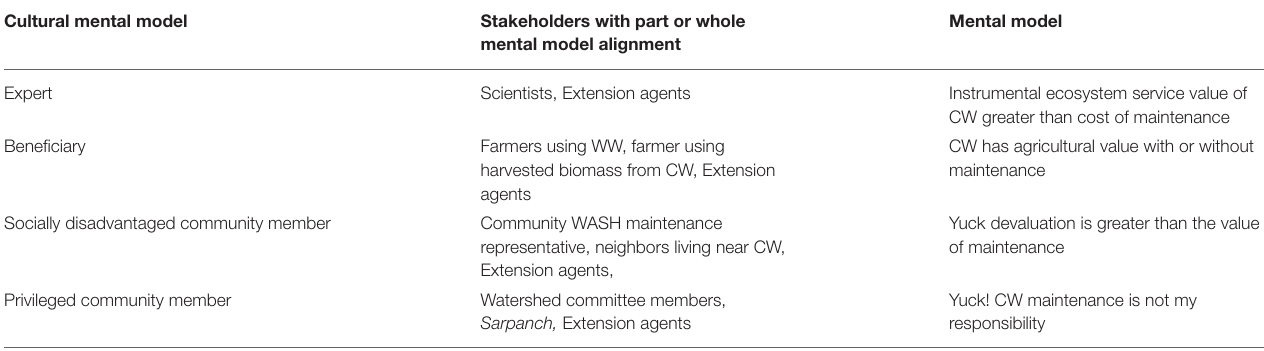
TABLE 2 | Stakeholder groups, cultural models and mental models of CW maintenance.